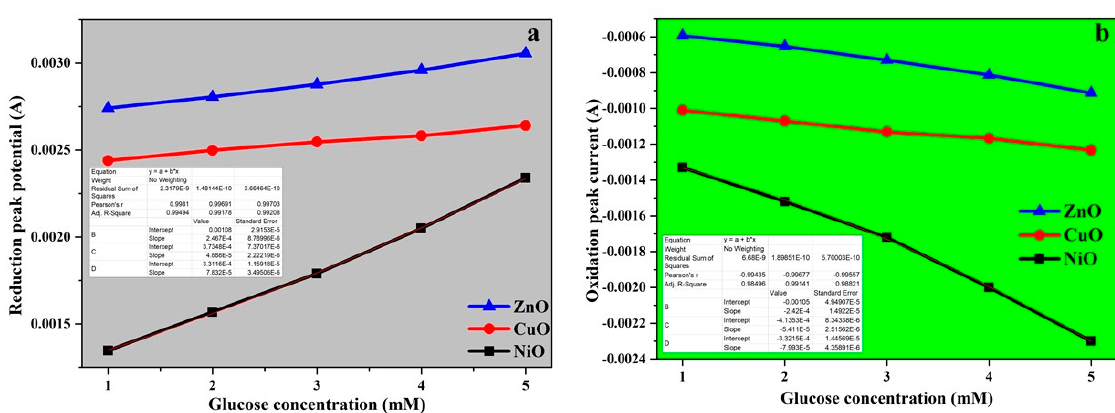
Figure 13. ( a ). Oxidation peak current response vs. Glucose concentration with fitted data, ( b ). Reduction peak current